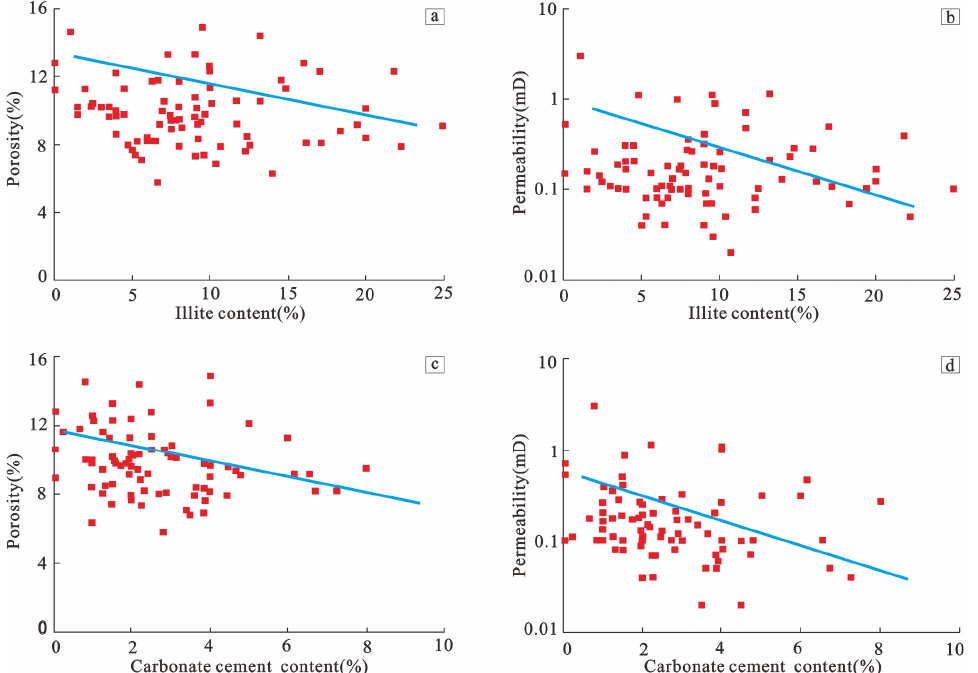
Figure 11. Cross-plot of the relationship between the abundance of illite cement and carbonate cement and physical properties. ( a ): Cross-plot of illite cement and porosity. ( b ): Cross-plot of illite cement and permeability. ( c ): Cross-plot of carbonate cement content and porosity. ( d ): Cross-plot of carbonate cement content and permeability.